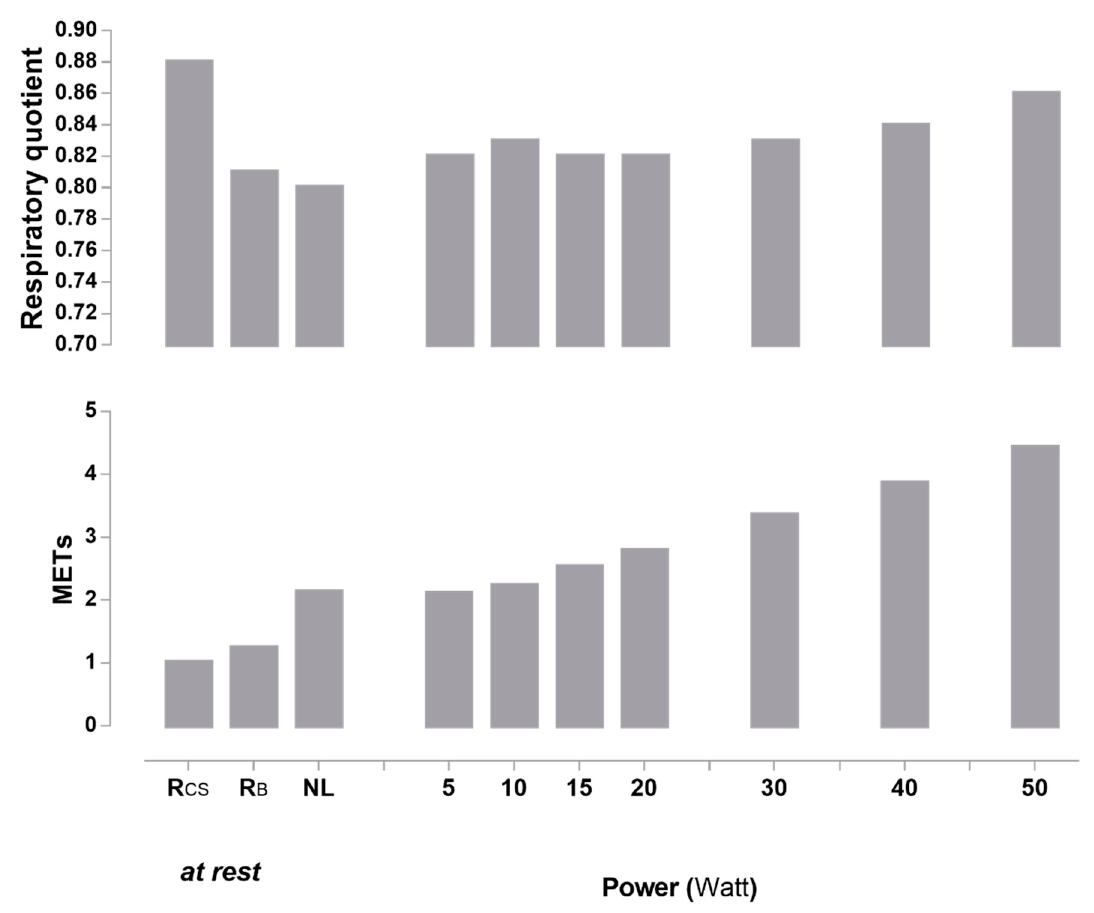
Figure 6. Respiratory quotient (upper panel) and METs (lower panel) at rest and in response to no-load (NL) cycling and across very low- to low-intensity cycling exercise. METs were calculated as the ratio of the work metabolic rate to the resting metabolic rate while sitting comfortably. Rcs: resting energy expenditure in car seat (baseline); RB: resting energy expenditure while sitting inactive (no cycling) on bicycle ergometer; NL = no-load cycling: sitting (bicycle) and cycling at 60 rpm at no-load; METs = metabolic equivalent of tasks.